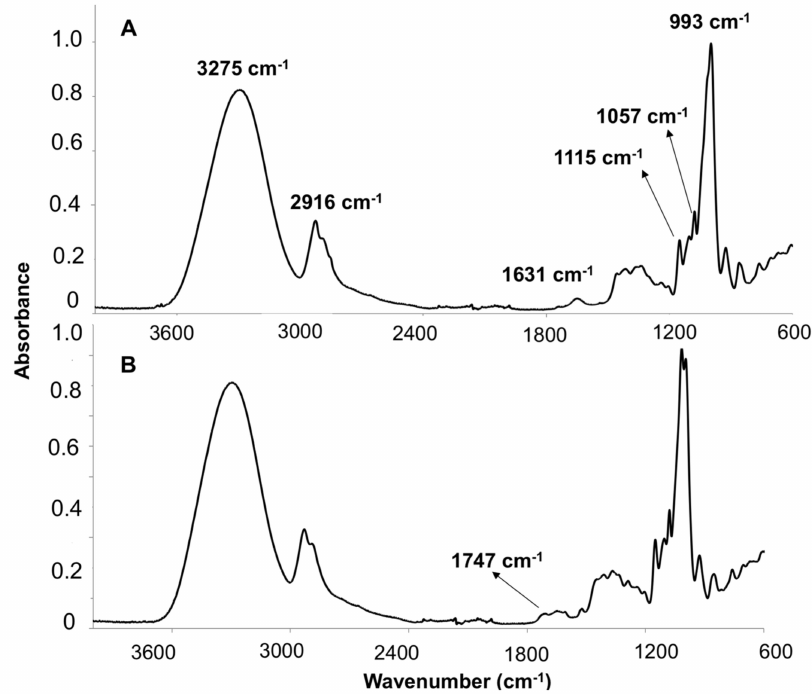
Figure 6. FTIR spectra of control film ( A ) and active film with 0.2 wt% of OE ( B ).